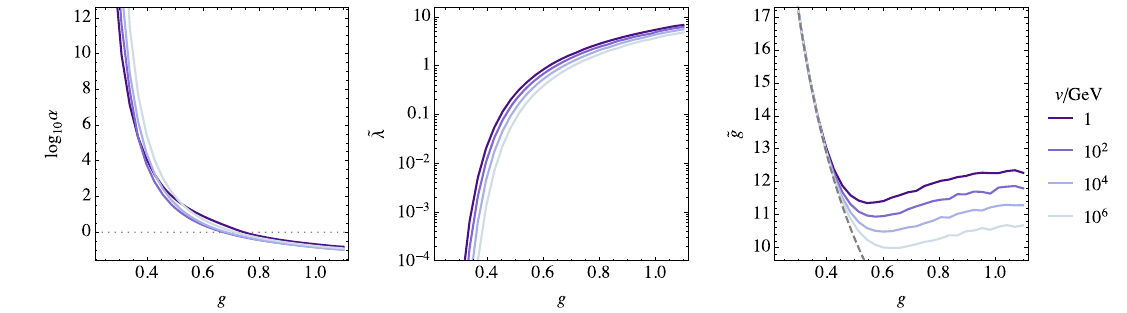
Fig. 1 The strength of the transition α , and the dimensionless parameters ˜ λ and ˜ g (see Eq. (A5)) as a function of the gauge coupling g . Different curves correspond to different values of v . The dashed curve in the right panel shows T = 0 limit of ˜